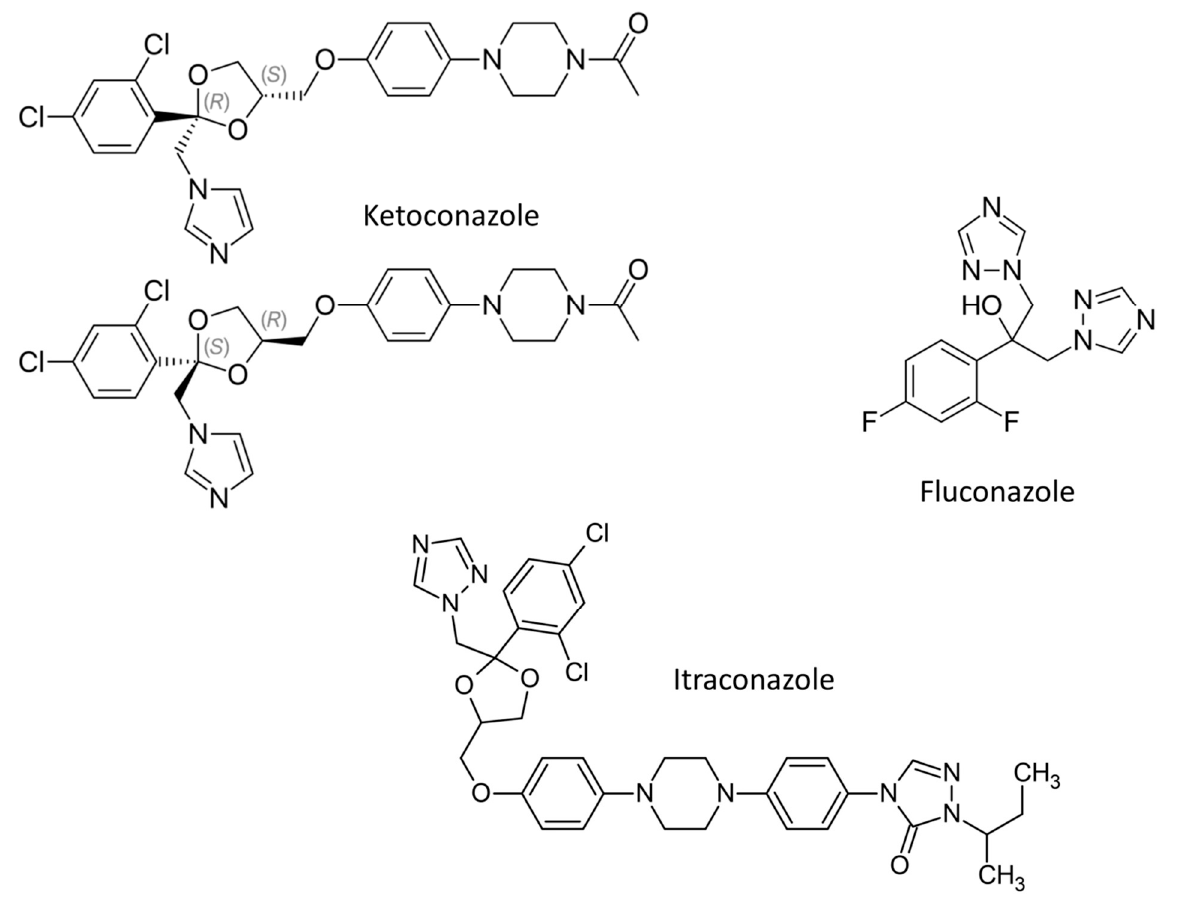
Figure 5. Chemical structure of azole derivatives used as systemic antifungal drugs. (S)—sinister enantiomer, (R)—rectus enantiomer.